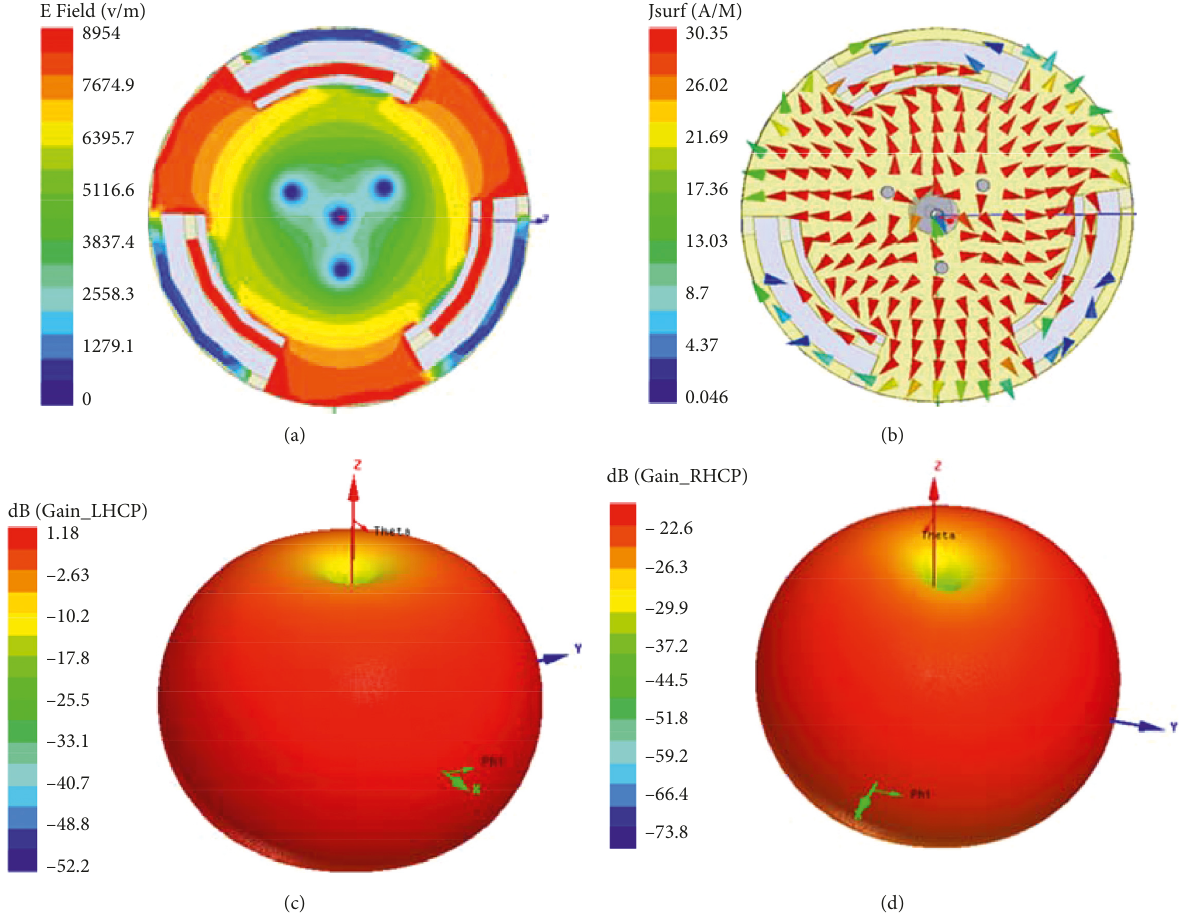
Figure 4: Energy and surface current distribution (a, b); radiation pattern plot gain LHCP (c) and gain RHCP